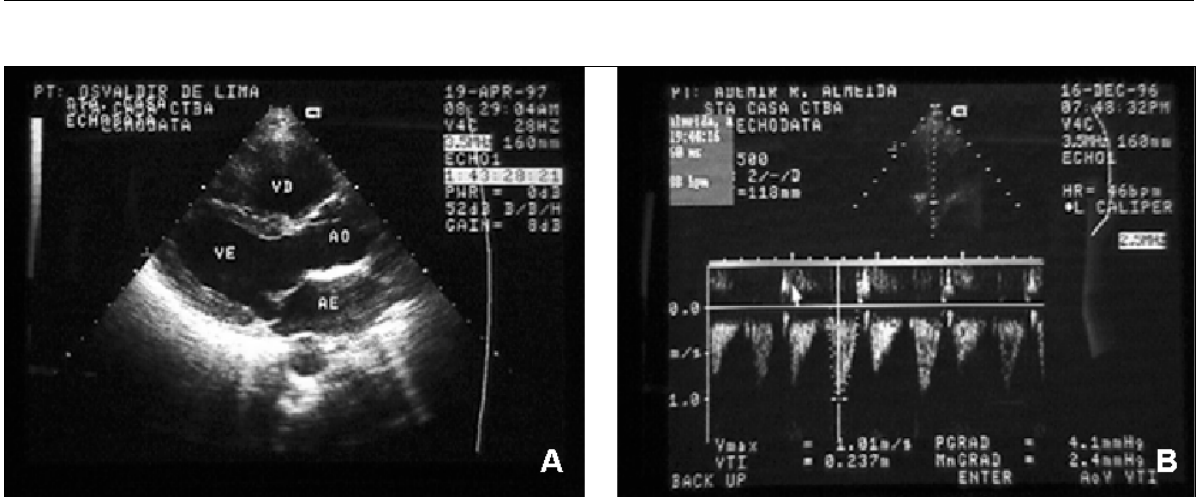
Fig. 3 - A- Imagem ecocardiográfica pós-operatória do auto-enxerto pulmonar em posição aórtica. B- Velocidade de fluxo e gradiente normal através do auto-enxerto pulmonar.